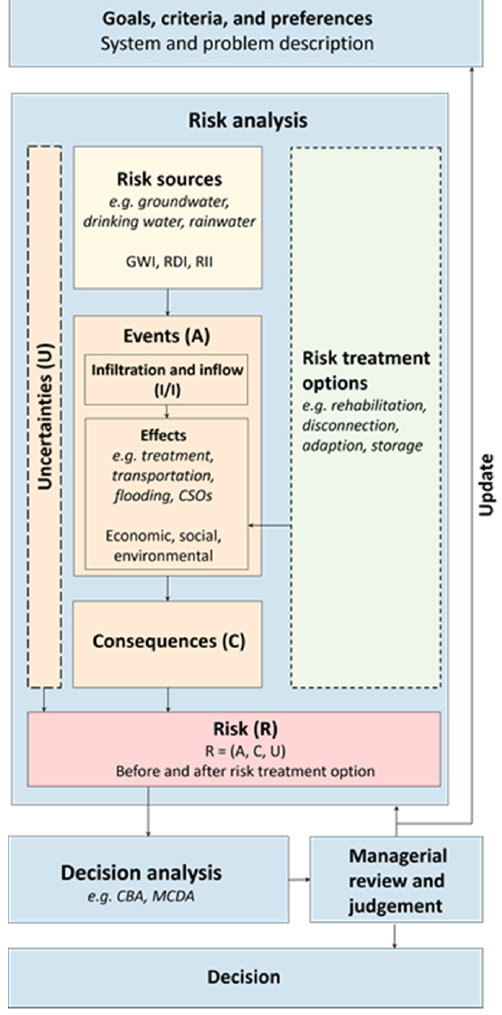
Figure 3. Suggested framework for risk-based decision support on I/I.